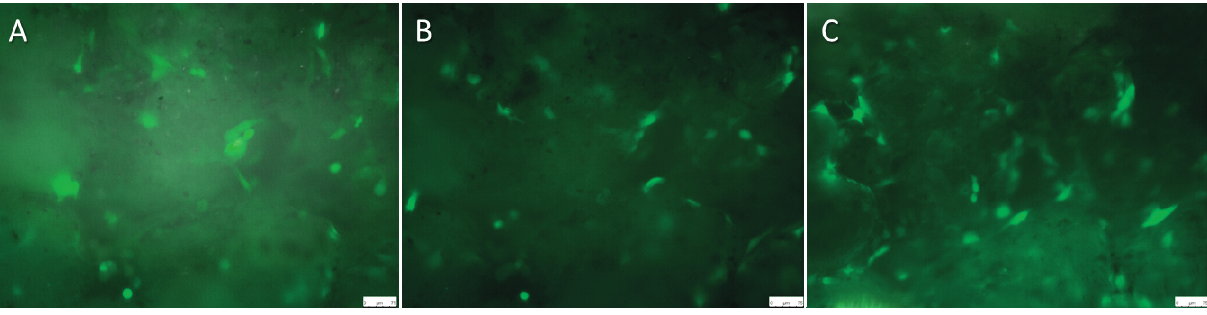
Figure 4. Osteoblasts seeded on the magnesium hybrid construct on Day 1 ( A ), Day 3 ( B ) and Day 7 ( C ). Scale bars: 75